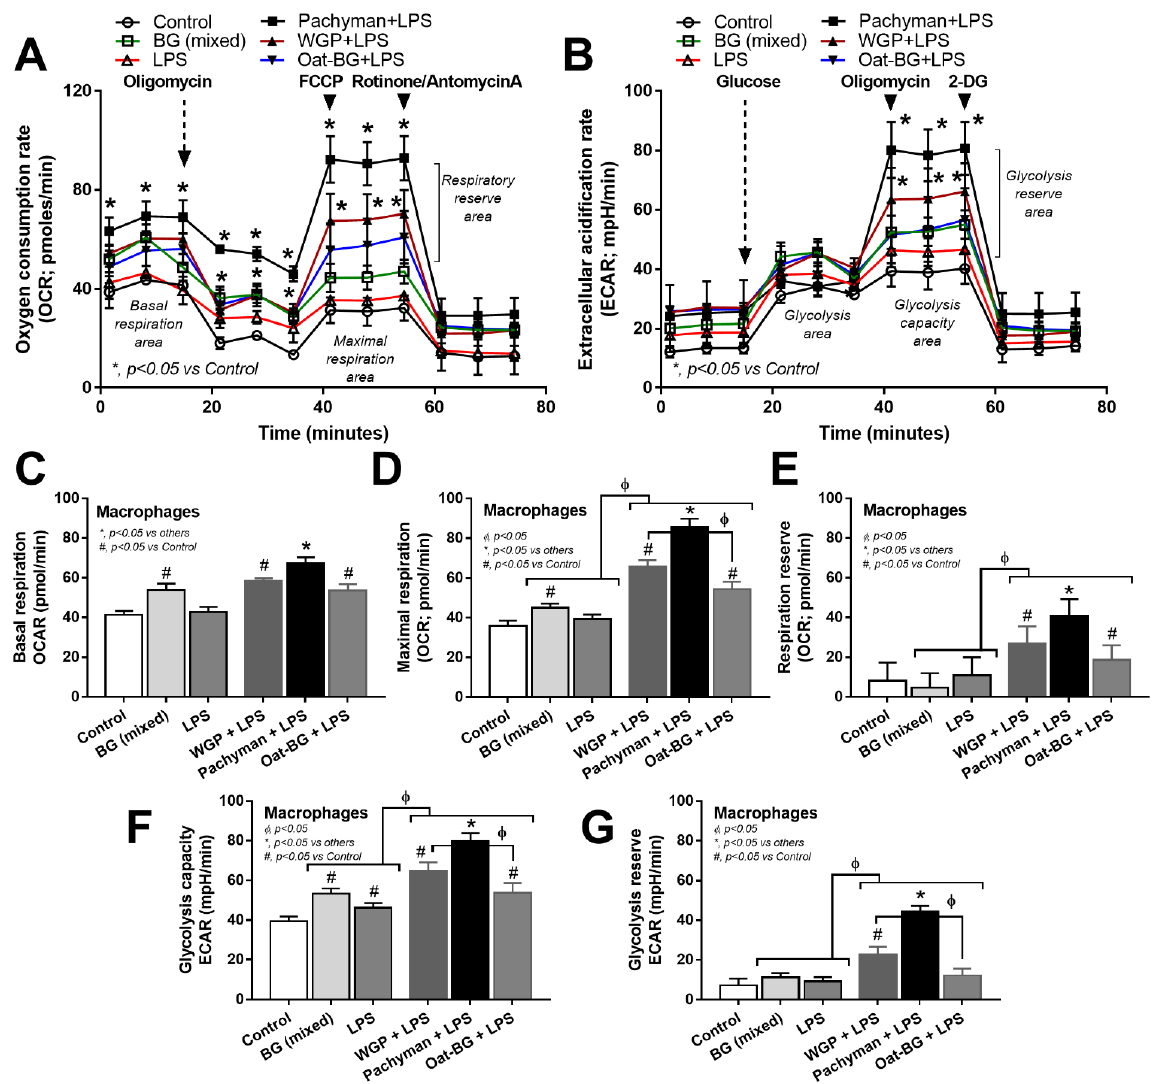
Figure 8. Characteristics of bone marrow-derived macrophages after 24 h of incubation in the control medium (Control) or with or without different forms of β -glucans using whole-glucan particles (WGP), Pachyman, or Oat glucans (Oat-BG), which are combined into the BG (mixed) group, or lipopolysaccharide (LPS) with or without these glucans. Extracellular metabolite flux analysis patterns, including oxygen consumption rate (OCR) of the mitochondrial function ( A ) and extracellular acidification rate (ECAR) of glycolysis activity ( B ) with the graph presentation of mitochondrial (basal respiration, maximal respiration, and respiratory reserve) ( C – E ) and glycolysis (glycolysis capacity and glycolysis reserve) ( F , G ) parameters, which are shown ( n = 6–8/group). #, p < 0.05 vs. Control; *, p < 0.05 vs. other groups; φ , p < 0.05 vs. the indicated group. ANOVA with Tukey’s analysis was used. Data from oral glucan-administered mice using different types of glucans were combined as BG (mixed) due to the nonsignificant differences between groups and independent triplicate experiments were